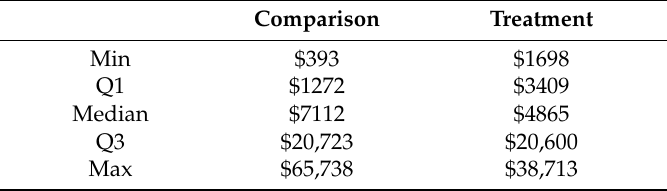
Table 8. Range of Ed/Hospital Visit Costs per Treatment and Comparison